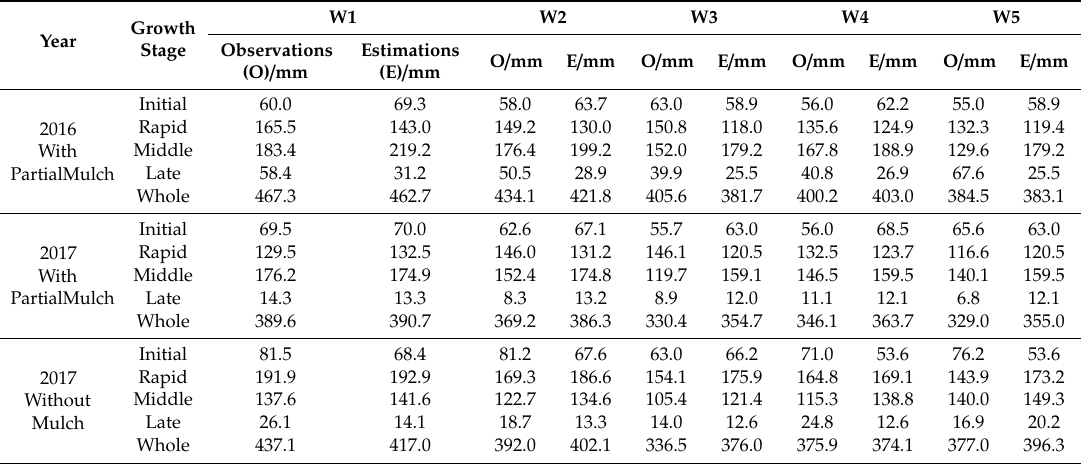
Table 7. Values of observed and estimated evapotranspiration at di ff erent growth stages of summer maize on partially mulched and non-mulched plots in Xinjiang,